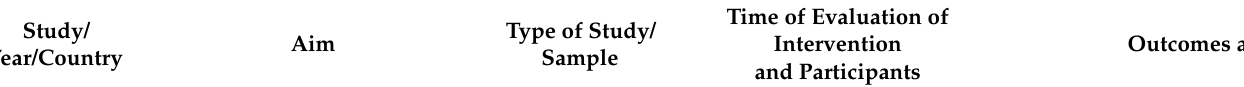
Table 2. Type of outcomes and results of studies. Lisbon,